Question: In one sentence, what is this figure communicating?
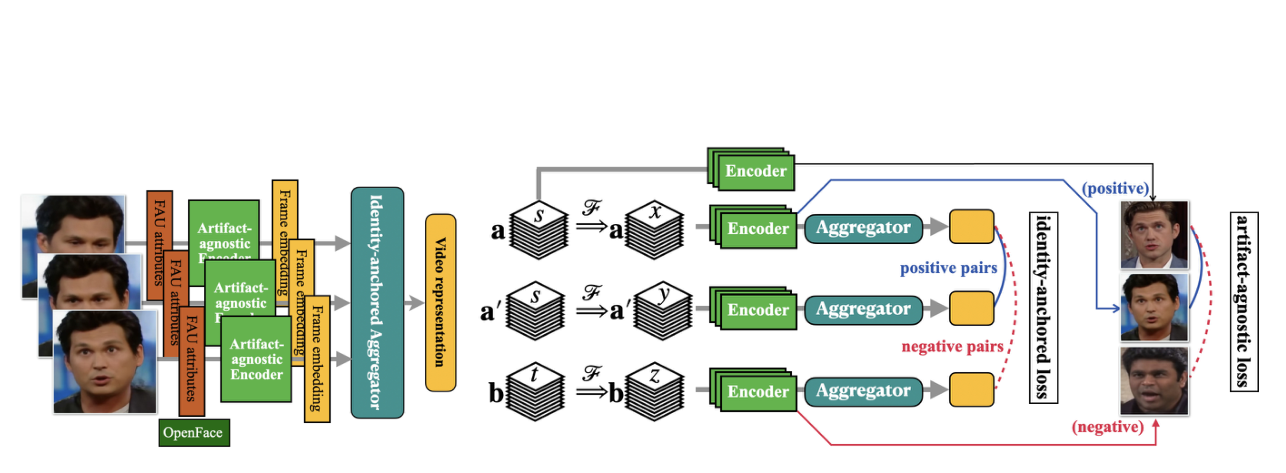
Answer: The architecture and training of ID-Miner. ID-Miner employs a hierarchical structure to extract embeddings with frame-level encoders from Facial Action Unit (FAU) attributes, then process the embeddings into a video-level representation. During training, the identity-anchored loss discriminates between video representations of the same individual’s action sequences (a and a′) and those of a different individual (b), irrespective of the facial appearances (x, y, or z). Concurrently, the frame-level encoder is trained by the artifact-agnostic loss to sample frames from videos pre- and post-deepfake transformation to prioritize encoding facial expressions and actions over artifacts.